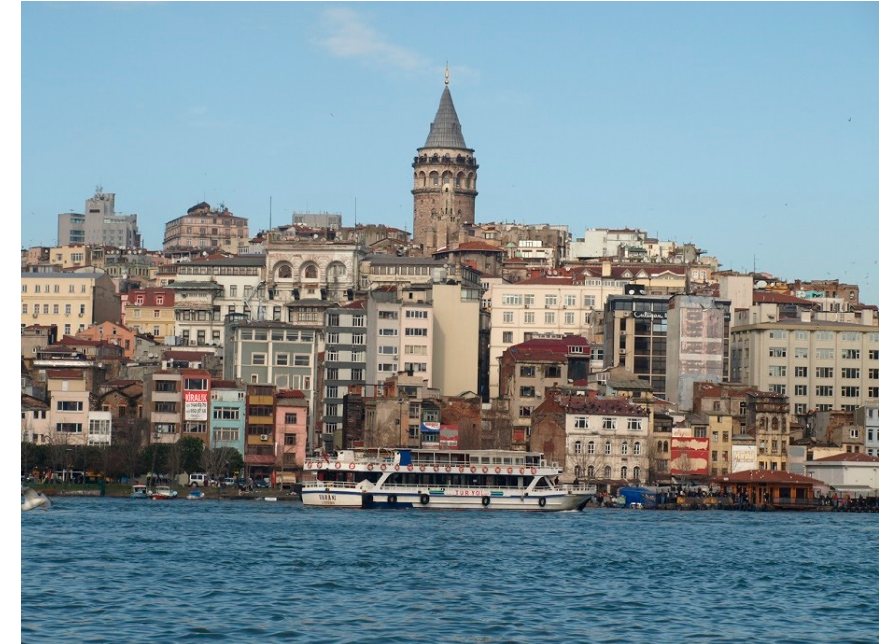
Figure 1. Pera seen from the opposite side of the Golden Horne, fot. R. Quirini-Pop ł awski.